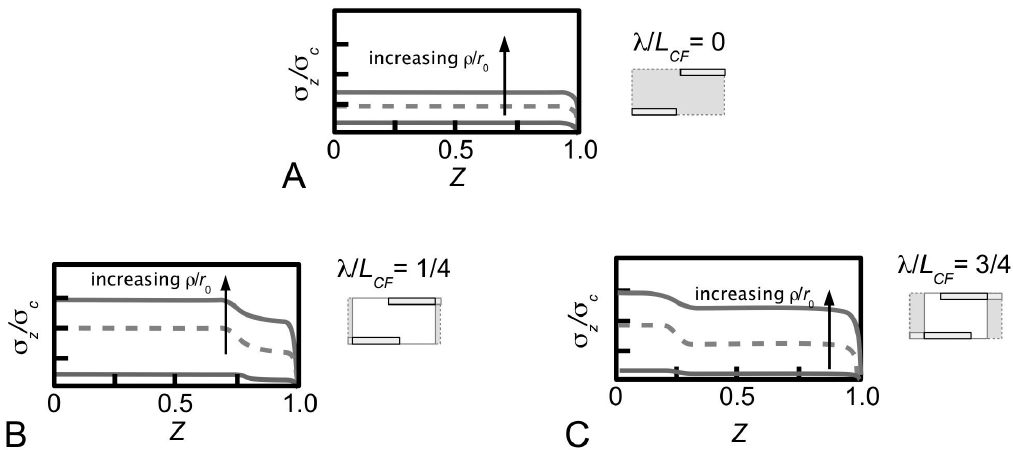
Figure 14. Fibril-fibril interaction. Sketches of the graph of axial tensile stress, σ z / σ c , in a fibril versus distance, Z , along the fibril axis (where Z = 0 and 1 correspond to the fibril centre and end, respectively) at ( A ) λ / L CF = 0; ( B ) λ / L CF =1/4 and ( C ) λ / L CF = 3/4 for the uniform cylindrical shape at varying fibril-fibril separation distance, ρ / r o , adapted from the report of Mohonee and Goh [130]. Insets (right of each graph) show representative volume elements (RVEs, Figure 13) of fibrils embedded in the matrix at different overlap distance. In the report of Mohonee and Goh, all results have been obtained by setting the ratio of the stiffnesses of the fibril to the matrix, E CF / E m , equal to 10 2 (“low”) and the fibril aspect ratio q = 650 (“high”). Symbol σ c represents the applied stress acting on the tissue in the direction of the fibril, L CF represents the half-length of the fibril and r 0 represents the fibril radius (for the tapered fibril, this refers to the radisu at the fibril